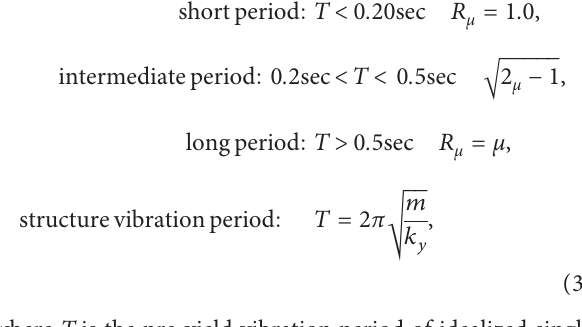
Figure 15: Simulation of roof displacement time history response in SeismoStruct. (a) Model-M Model-M RC2 having RC haunches both below and above